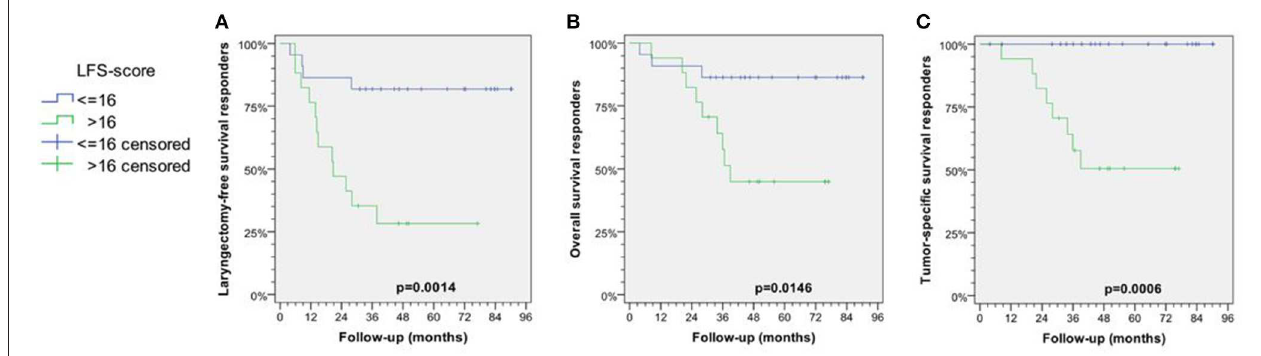
FIGURE 3 | Kaplan-Meier curves for laryngectomy-free survival (LFS; A ), overall (OS; B ), and tumor-specific survival (TSS; C ) among responders stratified according their LFS score ≤ 16 vs. > 16 are shown together with p -values from log-rank tests. Modified reproduction from Wichmann et al. (31); permission for reuse kindly provided by